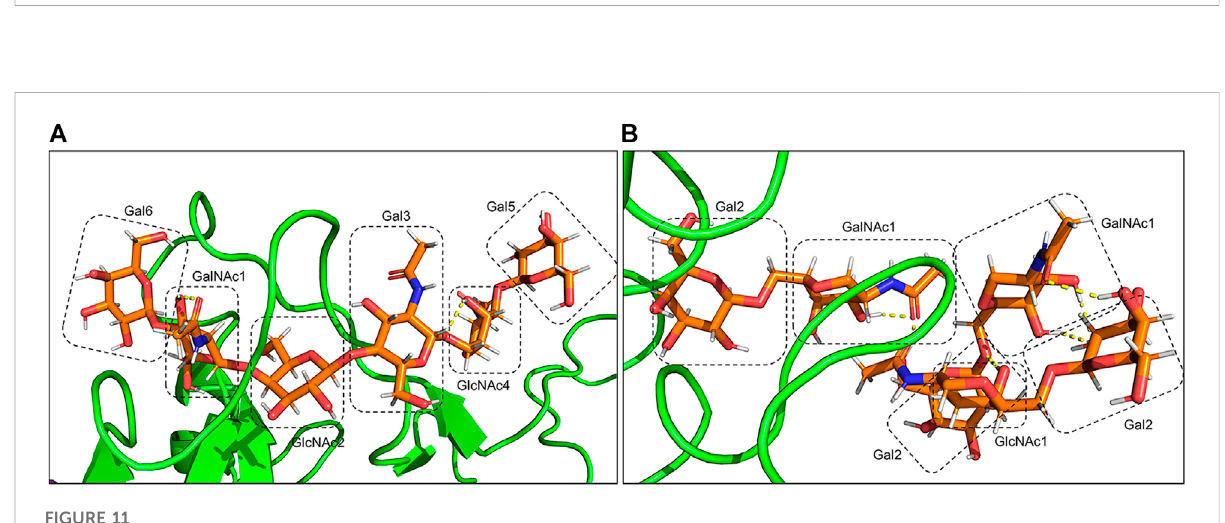
FIGURE 11 Hydrogen bonds between O-glycans of the gmRBD are shown in yellow dashed lines. (A) O-glycan attached to Ser494, and (B) additional O-glycans attached to Ser386,388 and